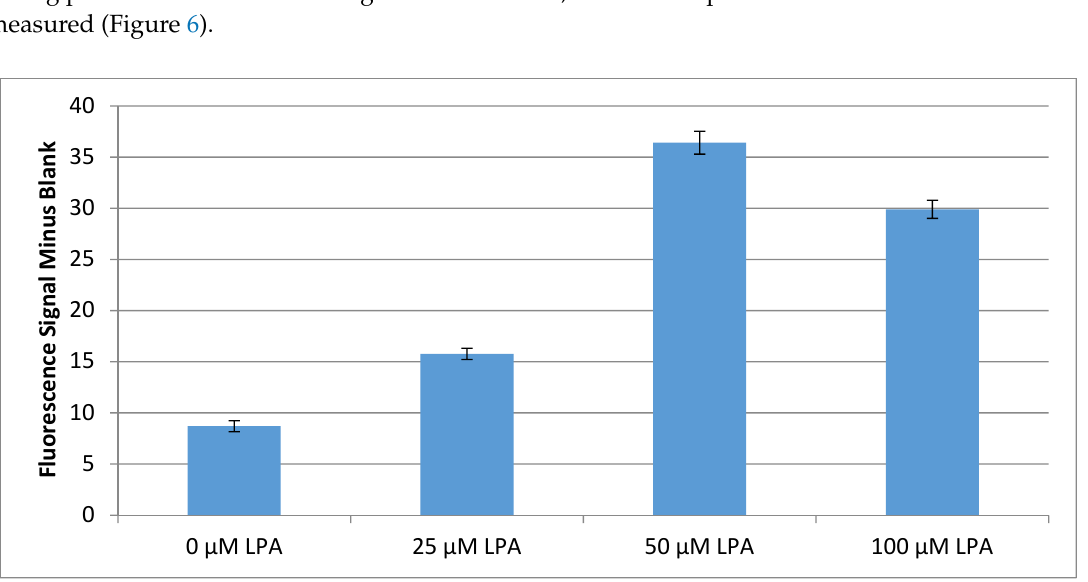
Figure 6. Fluorescence results for silica gel tests incubated in serum samples for 20 min.